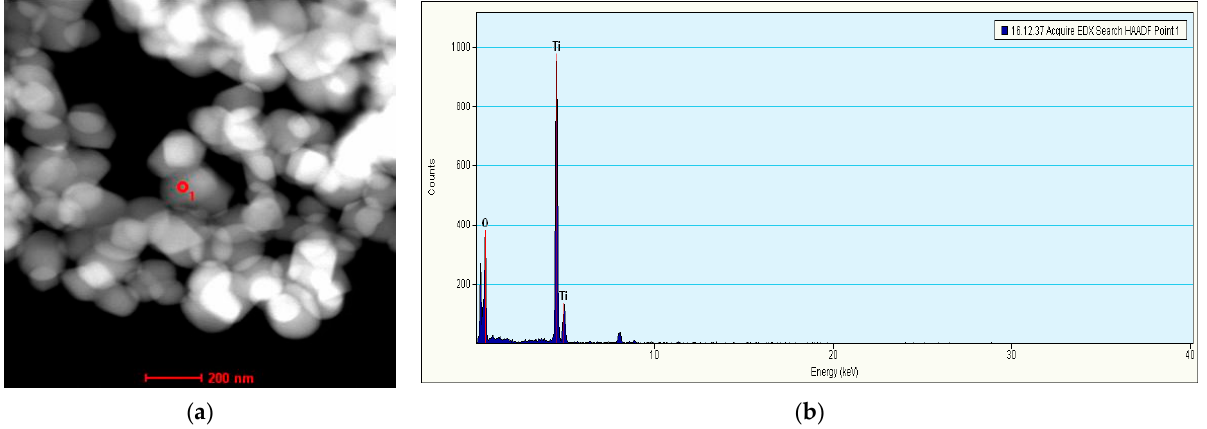
Figure 1. ( a ) Transmission electron microscopy image of TiO 2 ; ( b ) Energy dispersive spectroscopy image of TiO 2.